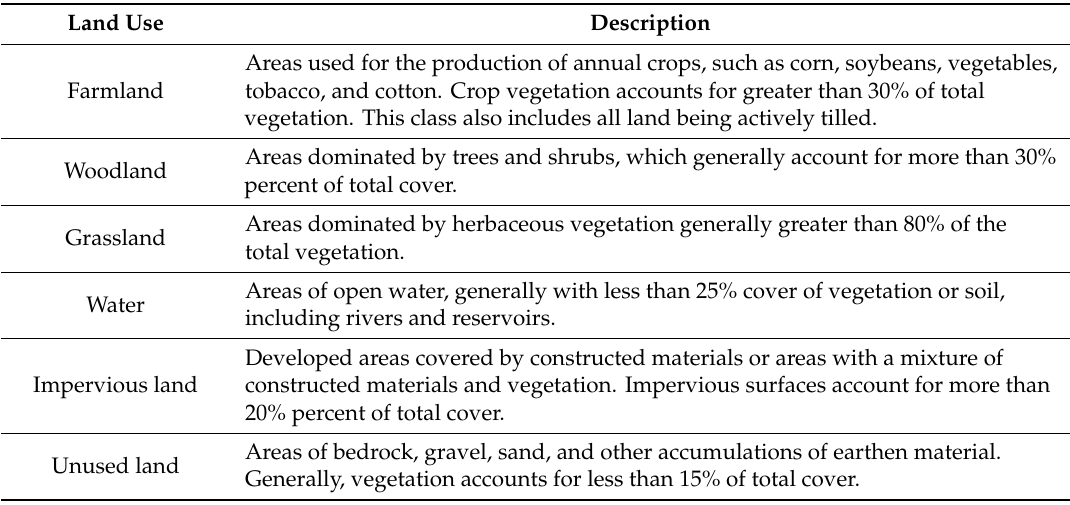
Table 1. Land use classes and description used in this